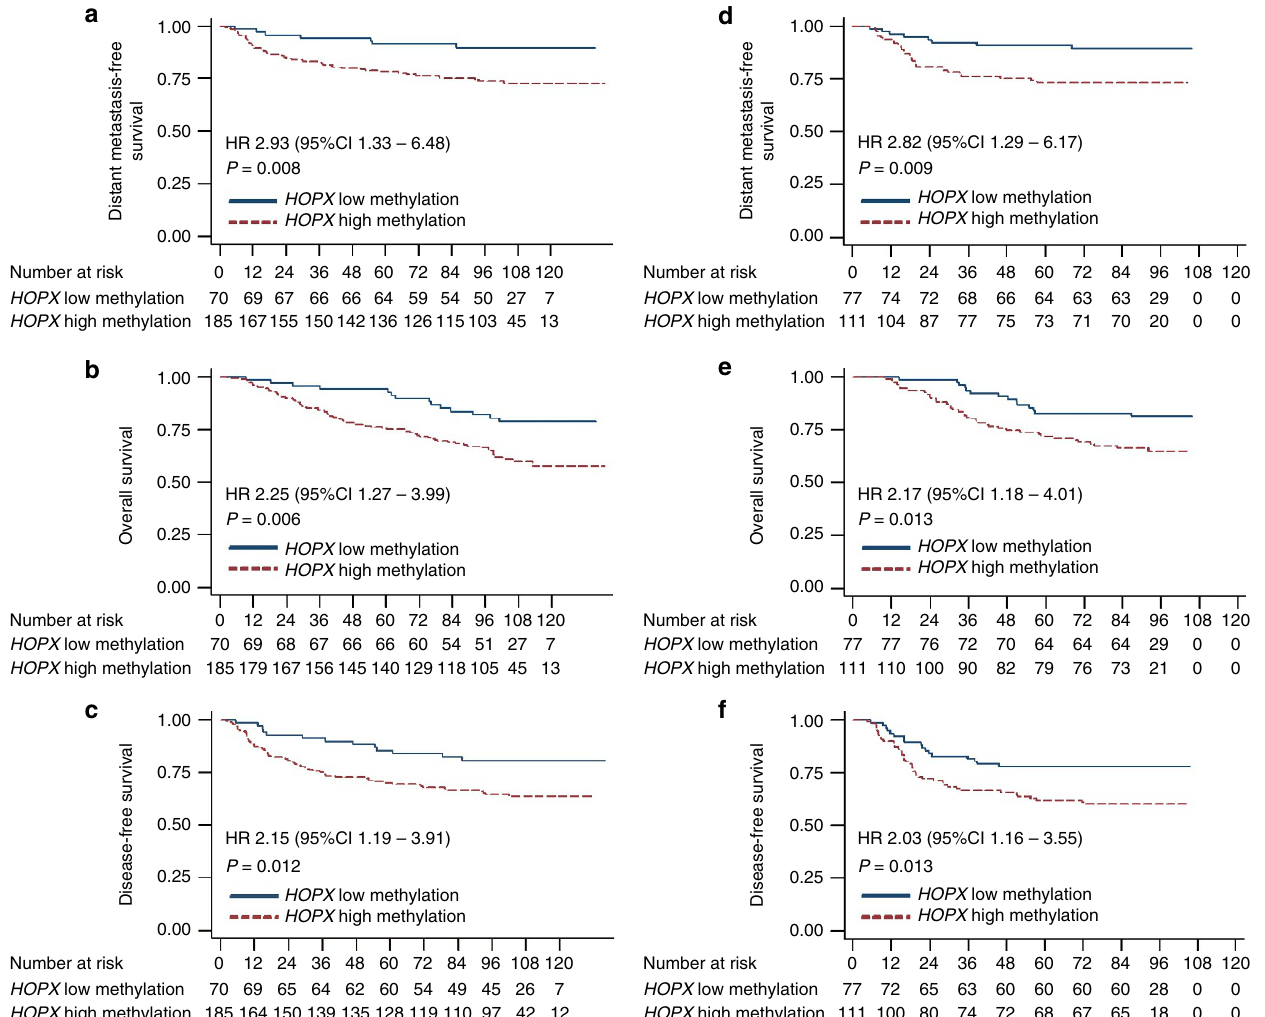
Figure 10 | HOPX hypermethylation is associated with poor prognosis in NPC. HOPX methylation levels were determined via bisulfite pyrosequencing analysis. Kaplan–Meier analysis was performed to determine the DMFS, OS and DFS according to the HOPX methylation level (low methylation versus high methylation) in NPC patients. ( a – c ) DMFS ( a ), OS ( b ) and DFS ( c ) in 255 NPC patients in the training set. ( d – f ) DMFS ( d ), OS ( e ) and DFS ( f ) in 188 NPC patients in the validation set. Adjusted univariate Cox proportional hazard models were used to calculate the HR values and P